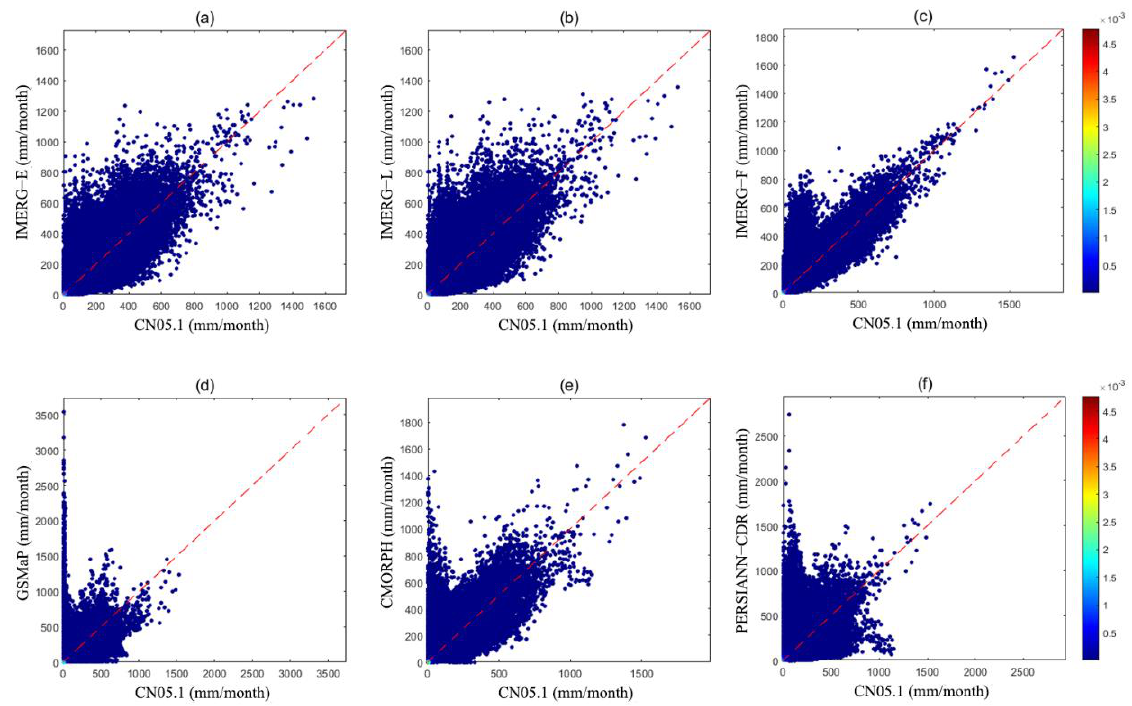
Figure 4. Scatter density plots of monthly precipitation for ground interpolation product (CN05.1) versus six satellite estimates: ( a ) IMERG – E, ( b ) IMERG – L, ( c ) IMERG – F, ( d ) GSMaP, ( e ) CMORPH, and ( f ) PERSIANN – CDR.